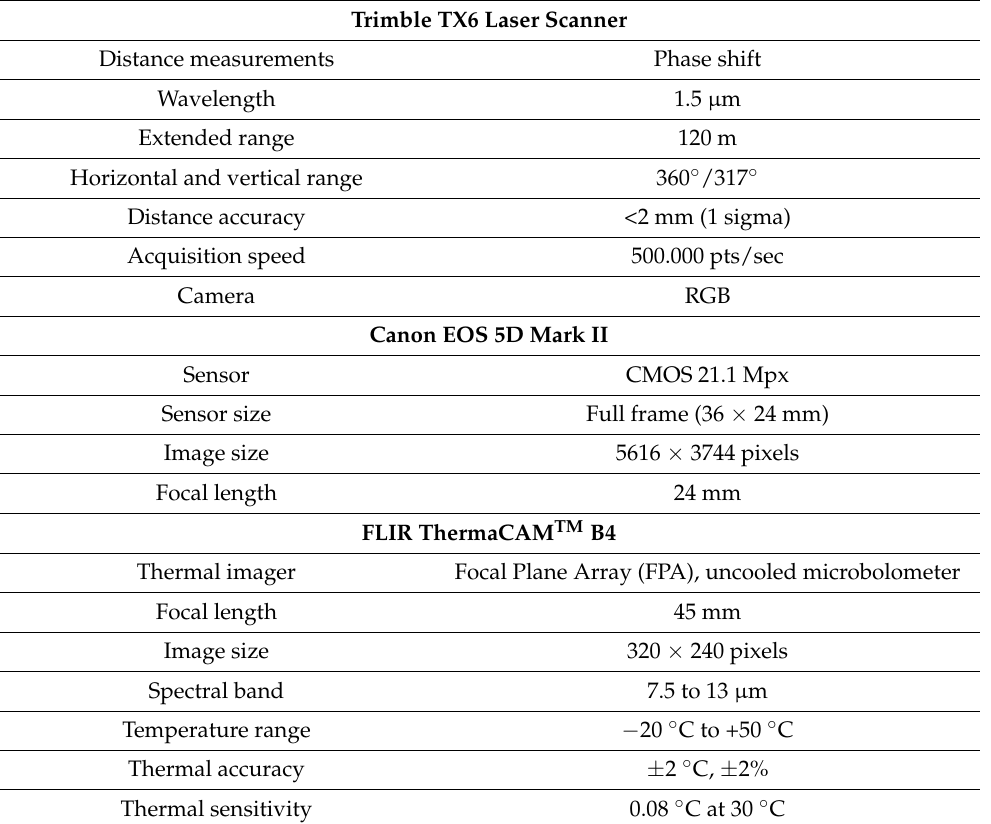
Table 1. Main specifications of the sensors used during the acquisition campaign (Trimble TX6 laser scanner, Canon EOS 5D Mark II, FLIR ThermaCAM TM B4).